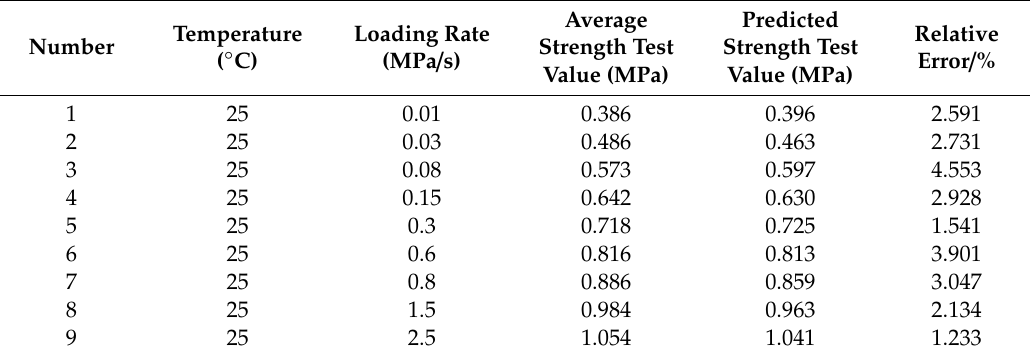
Table 12. Validation results of the strength prediction model.